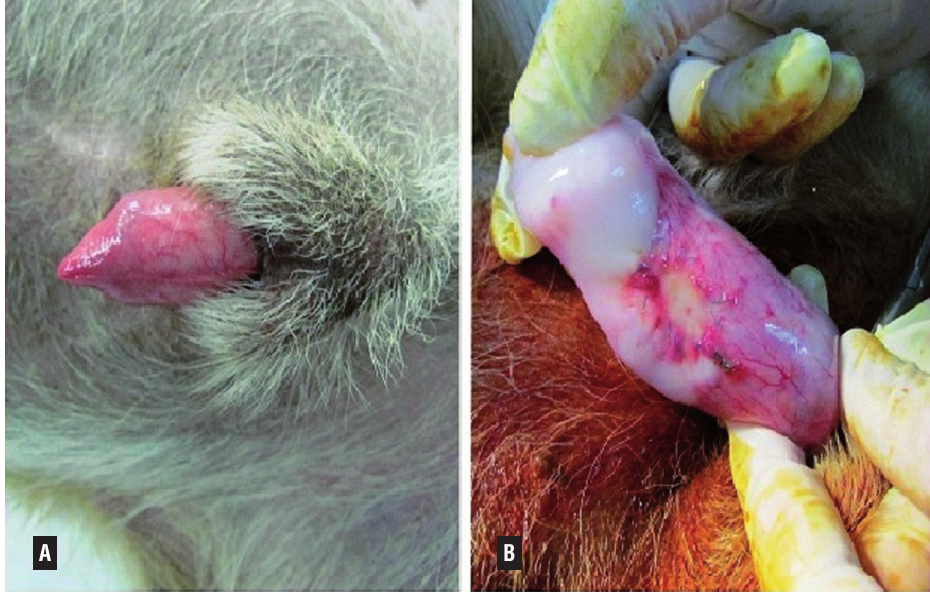
Figure 1 - The appearance of penile tunica albuginea before grafting (A) and 12 weeks after grafting